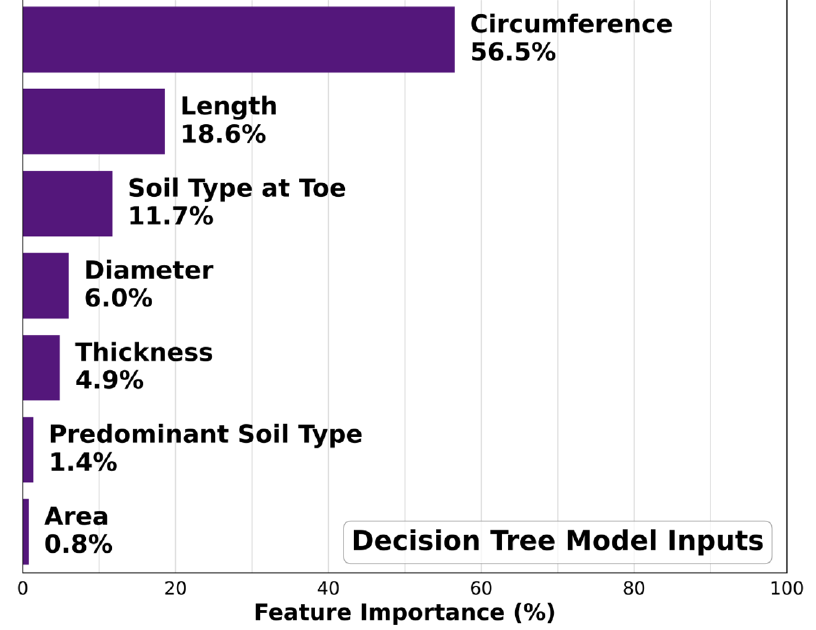
Figure 5. Feature importance for the decision tree model.